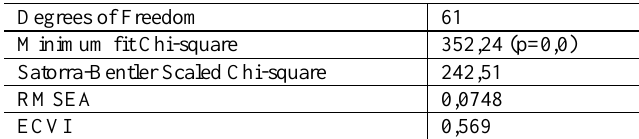
Table 3: Model fit indices